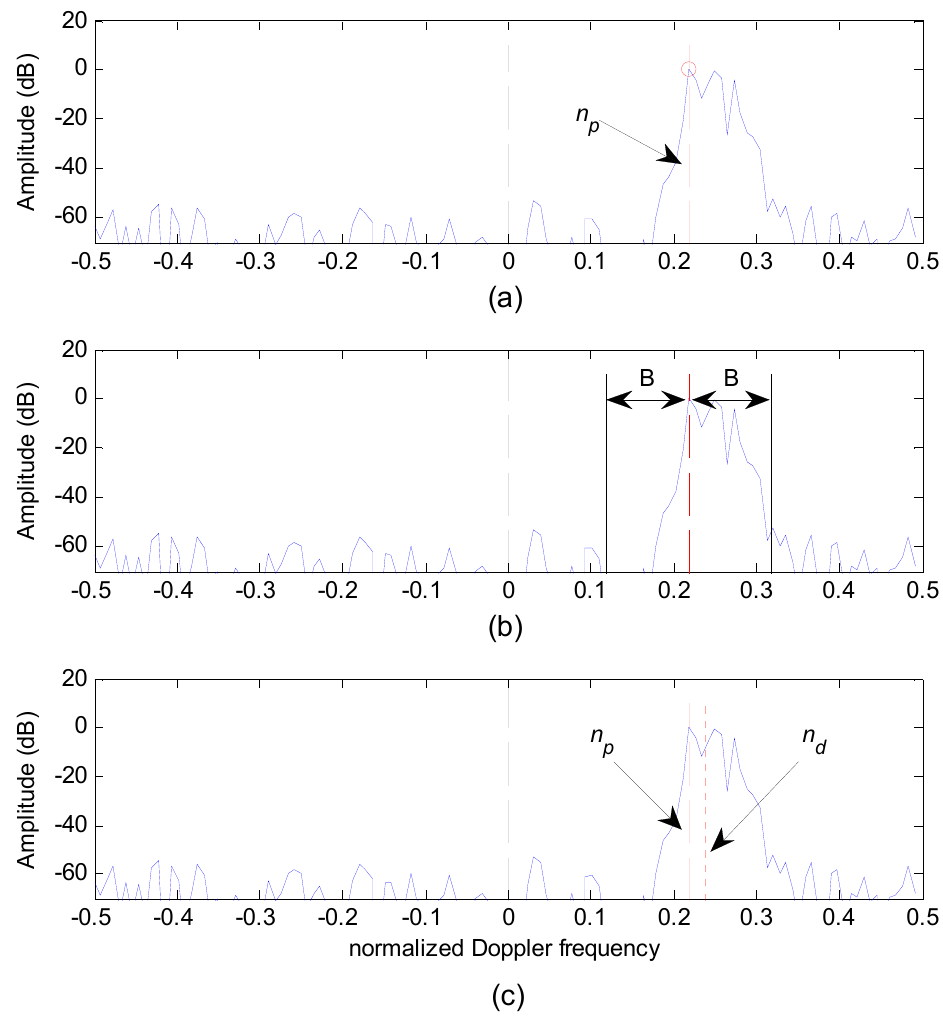
Figure 2. The proposed method is applied in 3 steps. ( a ) The spectrum peak (red circle) and the corresponding frequency n p are detected. ( b ) A frequency interval of extension 2B + 1 is centered around n p . ( c ) The centroid frequency n d is calculated in the detected interval. Red dashed and dotted segments report n p = 0.22 and n d = 0.24, respectively.